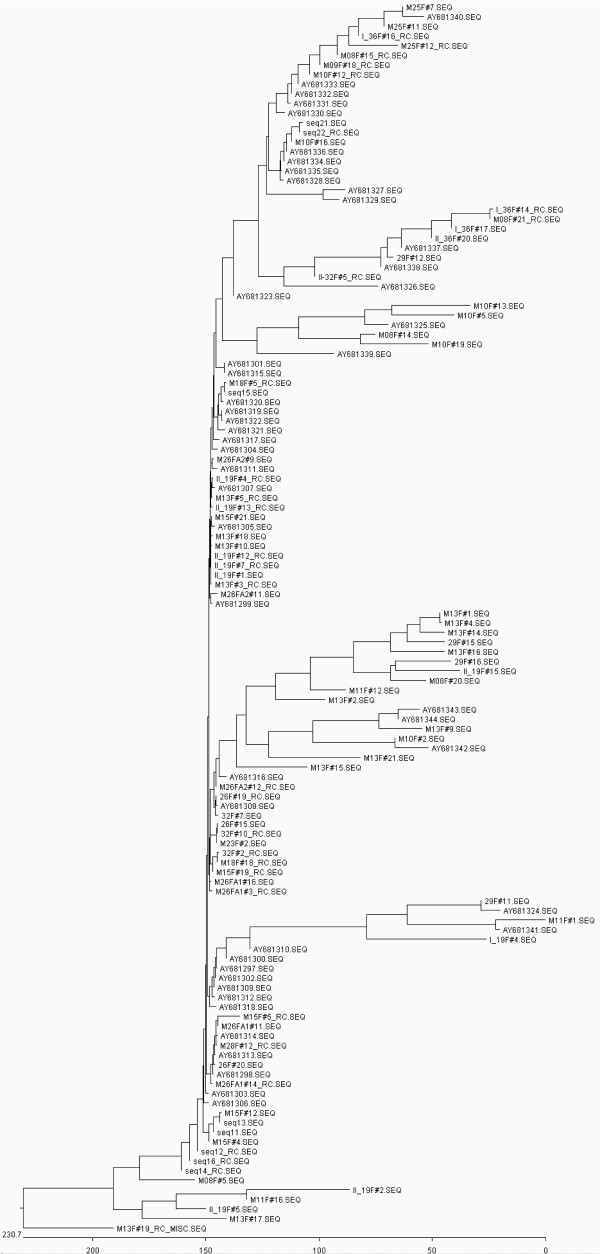
Philogenetic analysis. Nucleotide sequence alignment of the 80 novel non-identical sequences obtained by PCR with hybrid primers and Agelena sequences (sequence identifiers start with "AY" and correspond to their GenBank entries' names), obtained using EST based approach (as described in [6]). The branch length indicates the extent of sequence similarity.